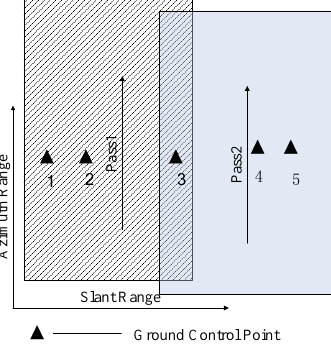
Fig.5 Needed GCPs for Two Passes with Single Pass Method However, if we estimate the parameters with block adjustment for multiple passes and multiple blocks, the minimum of needed GCPs is still 3. Here, we still analyze it with two passes, as is shown in